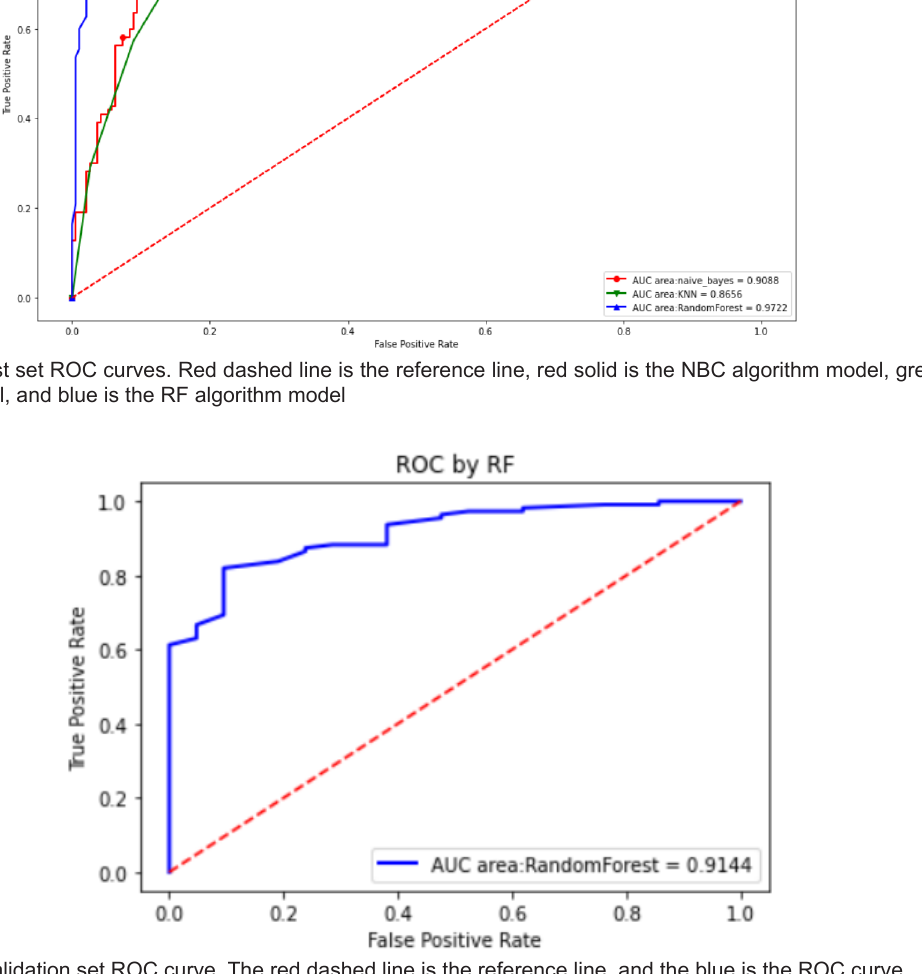
Figure 8. External validation set ROC curve. The red dashed line is the reference line, and the blue is the ROC